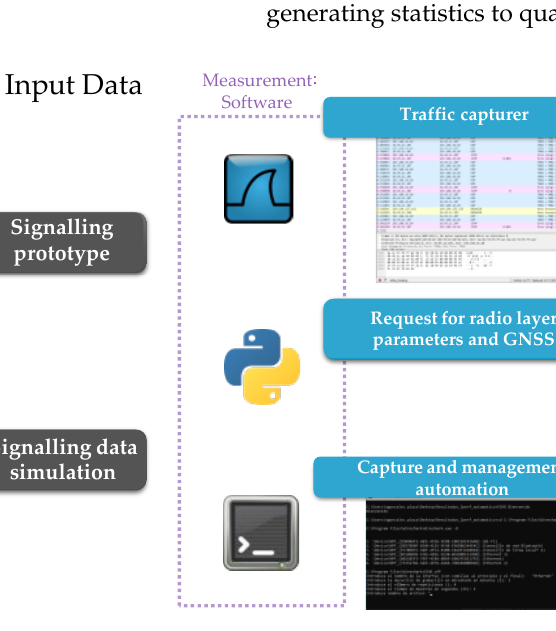
Figure 3. Software-distributed modules